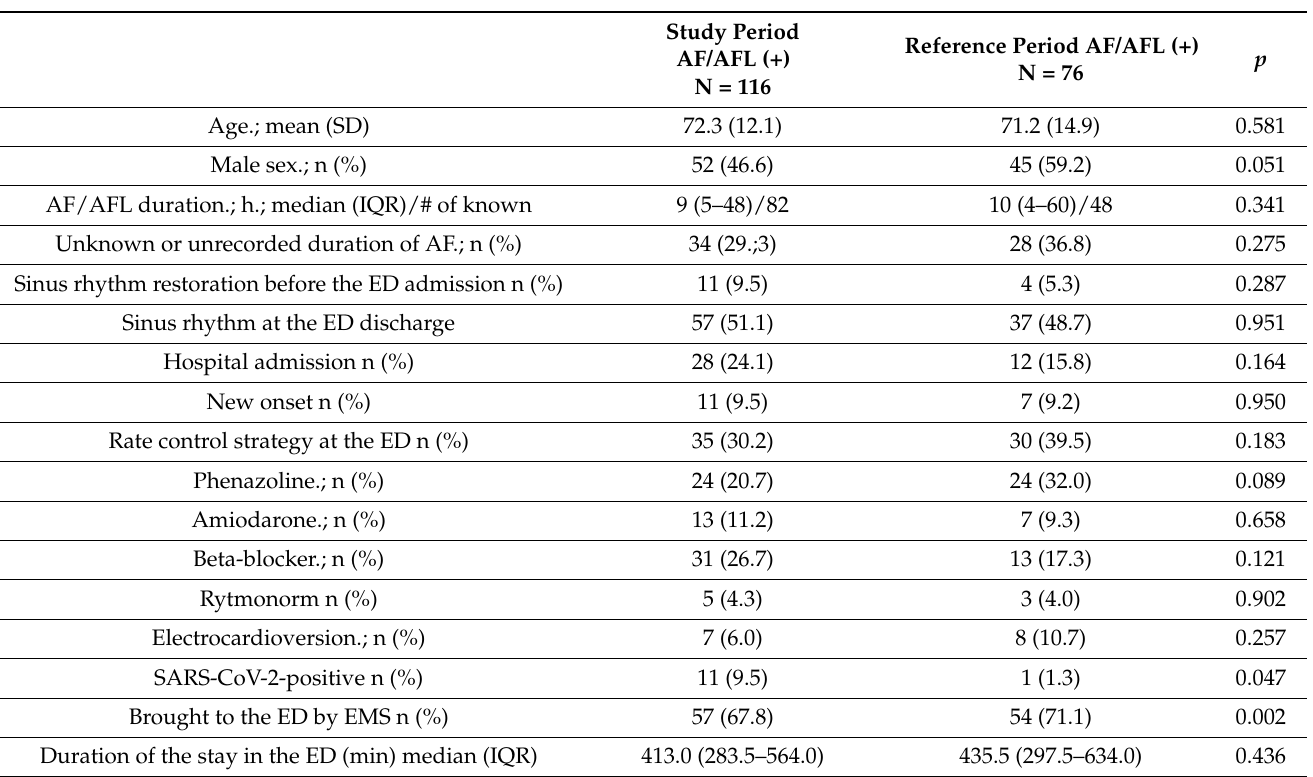
Table 1. The comparison of the patients admitted to the ED due to AF/AFL incidents admitted during the study and the reference period.